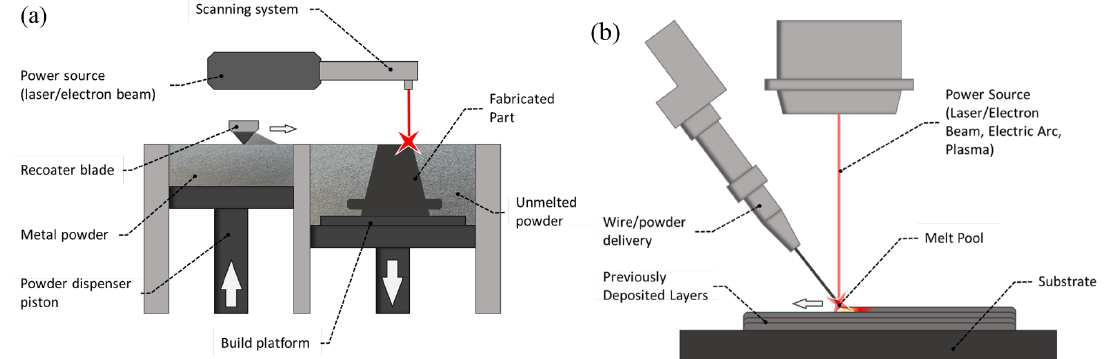
Figure 3. Schematic representation of: ( a ) powder bed fusion; and ( b ) directed energy deposition metal additive manufacturing